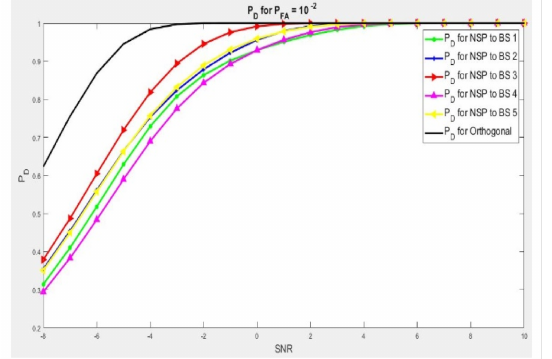
Figure 2. P D when dimension N ( H i ) = 1. And 3 to 6 dB more gain in NSR is needed to achieve 90% of target detection.